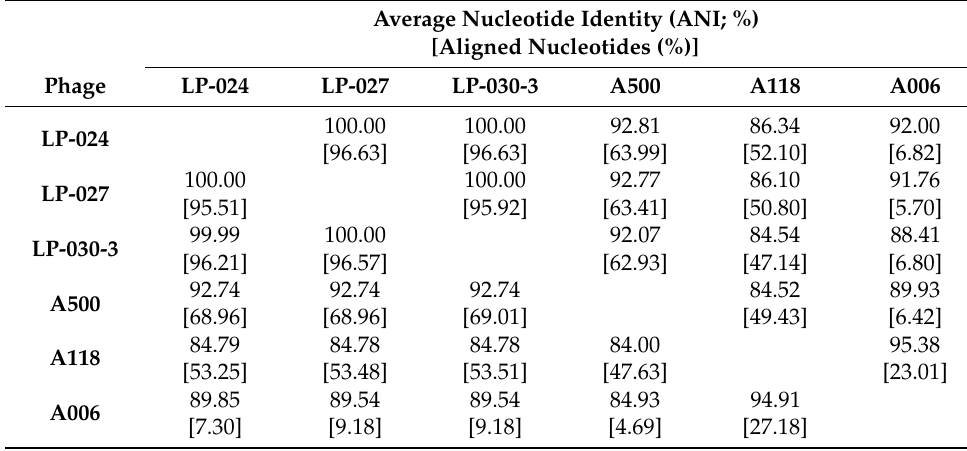
Table 5. JSpecies results for LP-030-03-like Listeria phages.